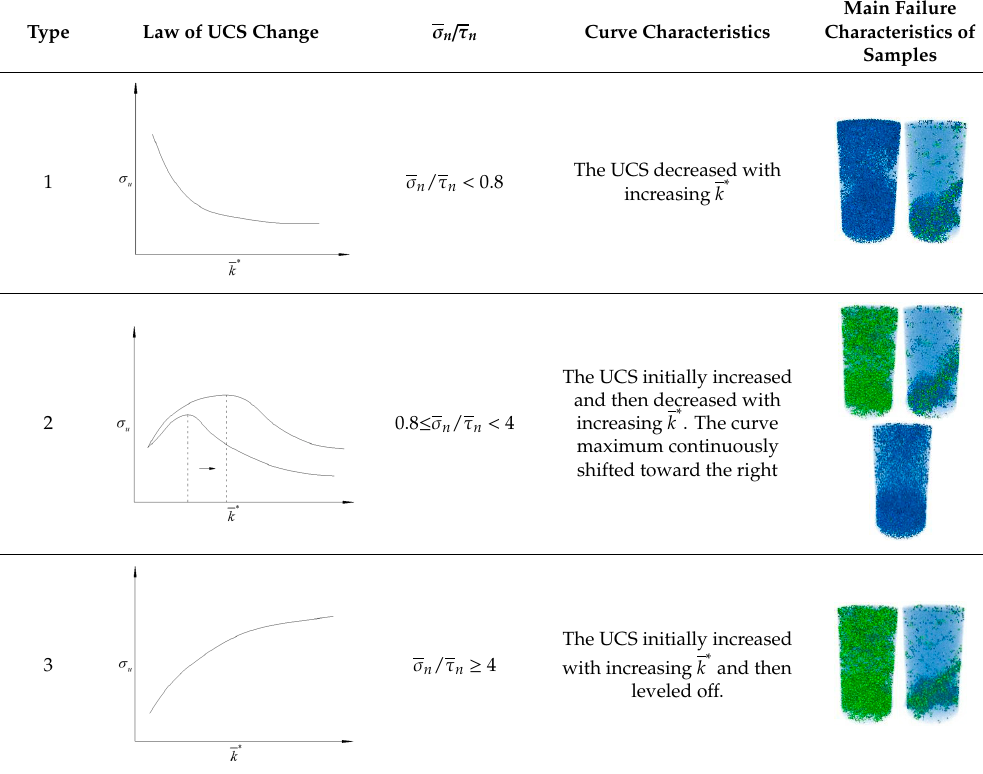
Figure 15. Changes in the bond stress state with parallel-bond stiffness ratio ( ( a ) Contact force chain (tension), ( b ) contact force chain (compression).